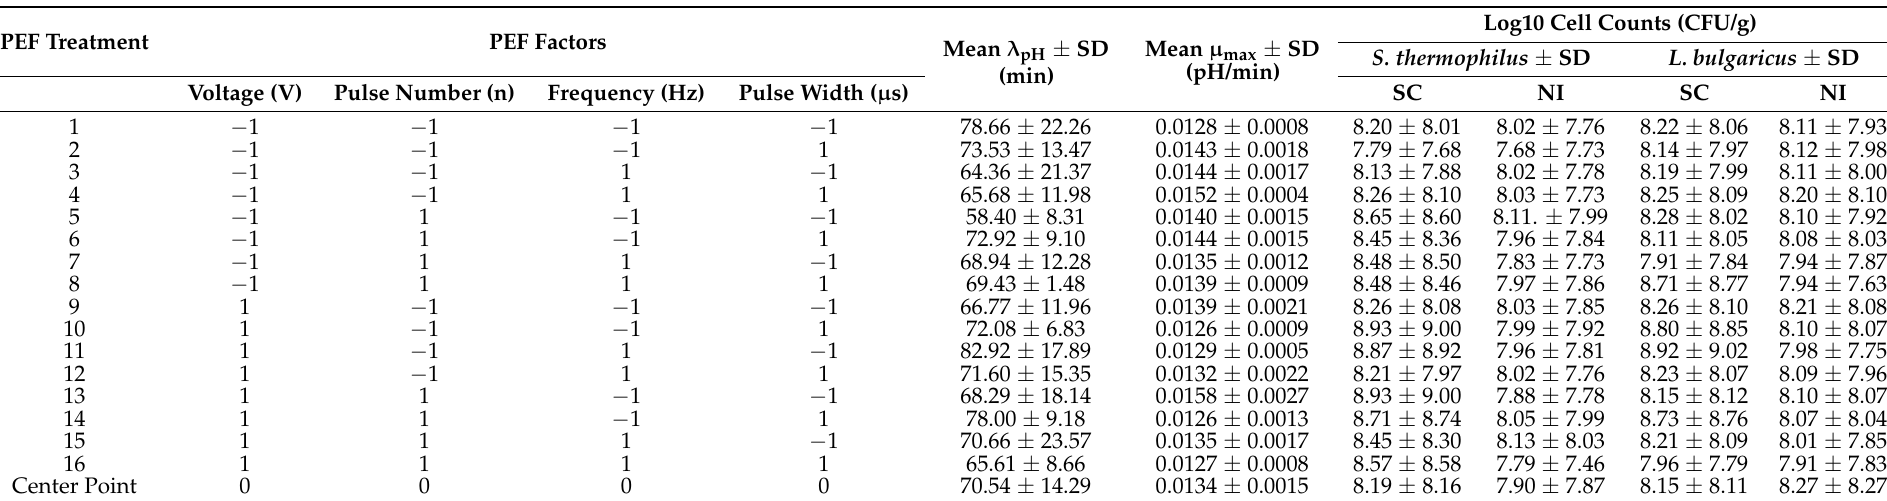
Table 1. Full factorial design with coded levels of PEF factors (voltage (V), pulse number, frequency (Hz), pulse width ( µ s)) for the yogurt fermentation experiments with PEF-treated starter